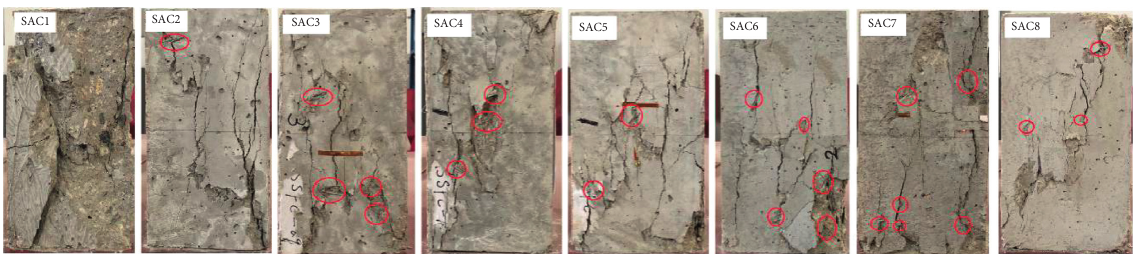
Figure 3: Typical failure patterns for prismatic